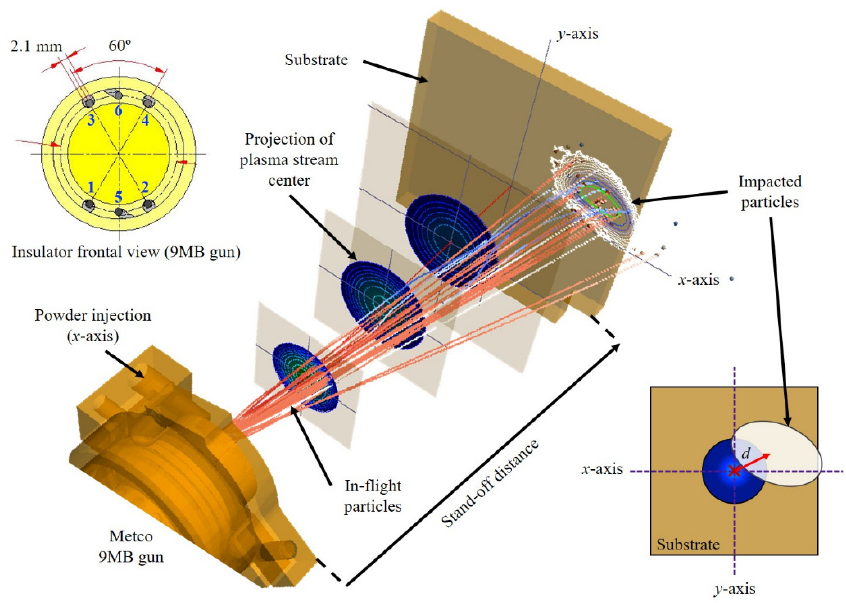
Figure 4. Schematization of simulation results of particles trajectories and the “ x ” and “ y ” displacements of the static footprints as a function of stand-off distance for Metco 9MB plasma torch. On the upper-left is shown the insulator frontal view into the Metco 9MB torch.